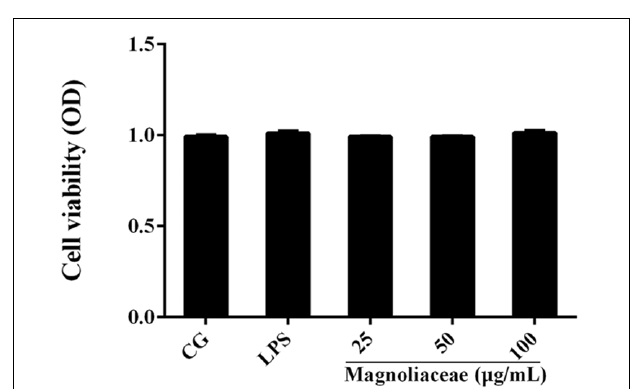
FIGURE 3 | The effects of magnoflorine on cell viability. RAW 264.7 cells were cultured with LPS (1 µ g/mL) and different concentrations of magnoflorine (25, 50, and 100 µ g/mL) for 12 h, and then the cell viability was measured using the CCK-8 assay. The values are presented as means ± S.E.M. of three independent